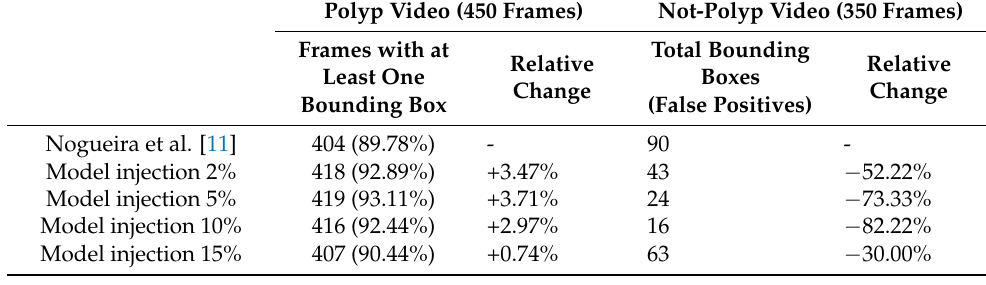
Table 6. Summary of the network predictions in both polyp and not-polyp videos. For the polyp video, the total number of distinct frames with at least one bounding box is reported, as a proxy of the recall (assuming that, at least one of the bounding boxes in the frame is placed over the polyp). For the not-polyp video, the total number of bounding boxes is reported, which are all false positives. Relative changes if these metrics are also reported among different models.